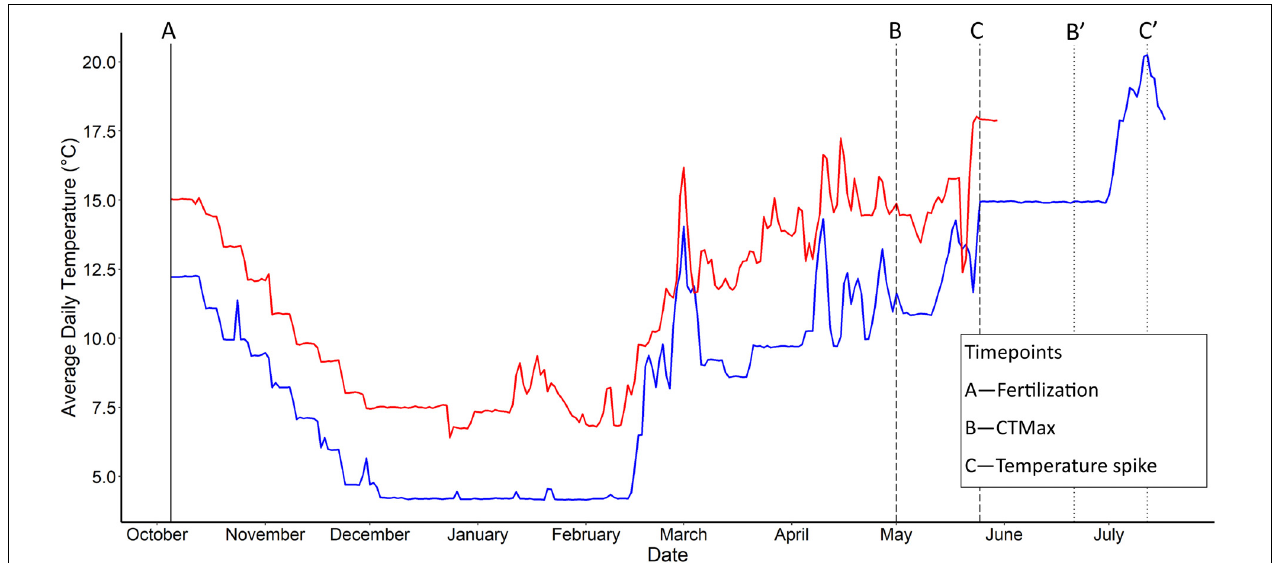
FIGURE 1 | Mean daily water temperature for the two rearing temperature regimes (in aquatic facility) examined in Chinook salmon ( Oncorhynchus tshawytscha ). Blue—current temperature regime (0 ◦ C) and red—elevated temperature regime (+3 ◦ C). Vertical lines represent sampling time points: solid—both current and elevated groups; dashed, (B,C) —elevated, dotted, (B (cid:48) ,C (cid:48) ) —current. Time points are: (A) —Fertilization (Oct 4th), (B,B (cid:48) ) —CTMax start date ( ∼ 14 ◦ C), and (C,C (cid:48) ) —Thermal spike start date ( ∼ 18 ◦ C). Modified from Figure 2 found in Warriner et al. (2020); Copyright (©) 2020 Warriner, Semeniuk, Pitcher, and